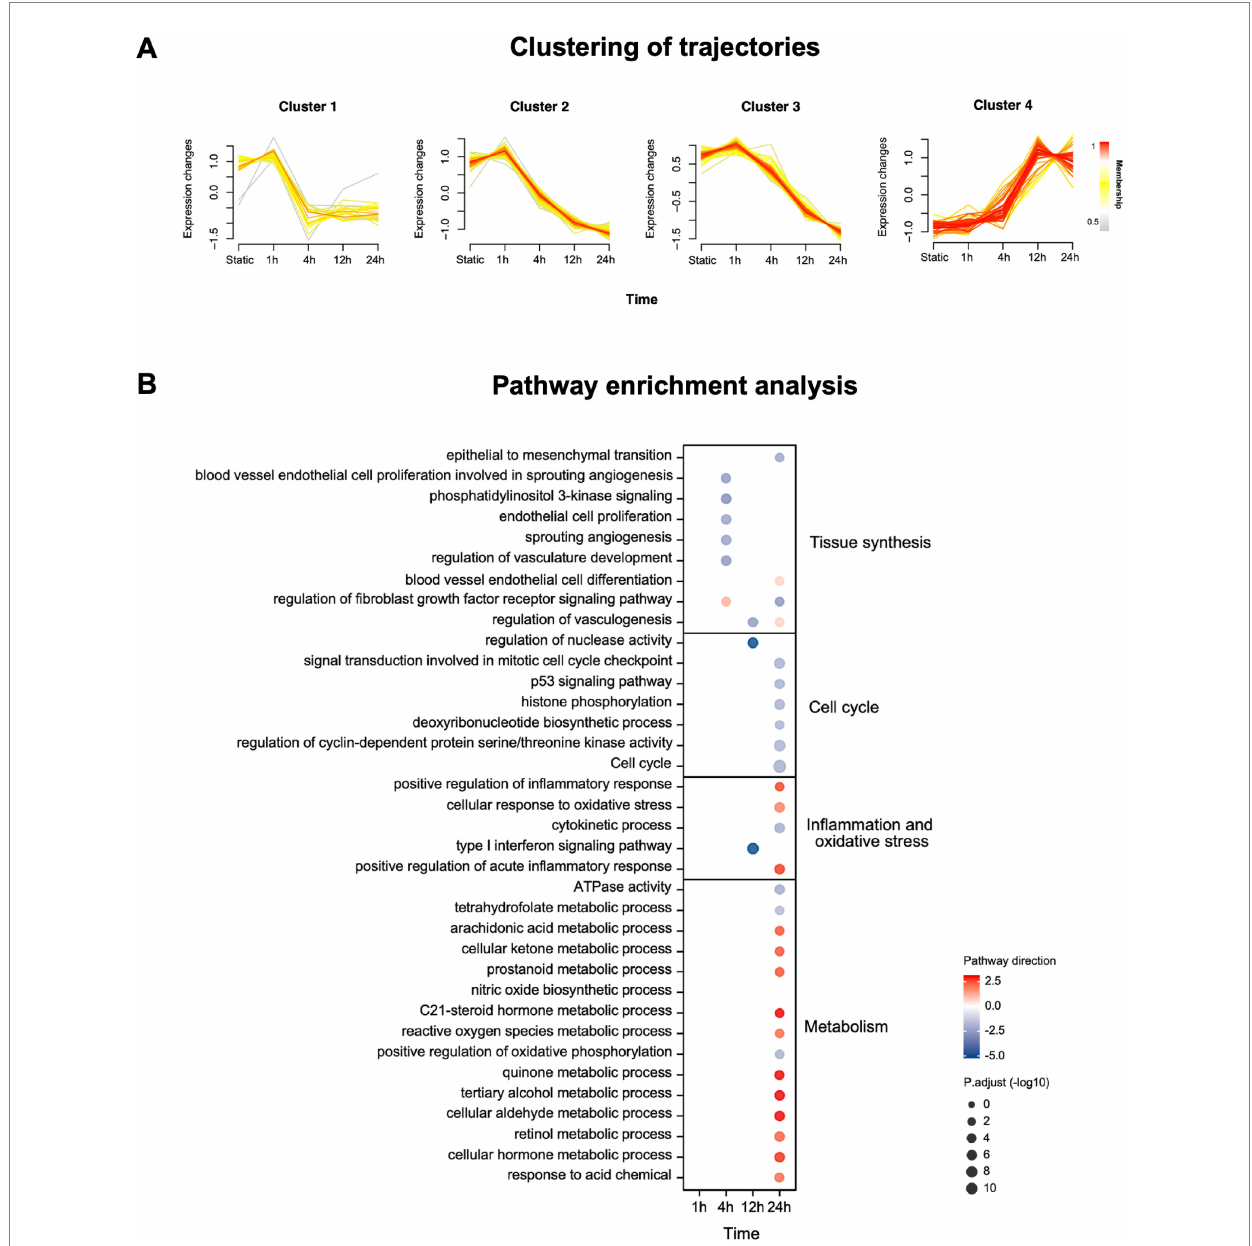
FIGURE 1 mRNA expression and enrichment of HUVECs under OS intervention. (A) Clustering of longitudinal gene expression trajectories (p.adj < 0.05). Membership represents the association strength between the sample and the cluster. (B) Pathway enrichment analysis using mRNA significantly changing in tissue synthesis, cell cycle, inflammation and oxidative stress and metabolism (p.adj < 0.05, |Log2 Fold change|>1). Pathway direction is the mean log2 fold change relative to baseline of significant transcripts in each pathway (blue, downregulated; red, upregulated). The dot size represents pathway